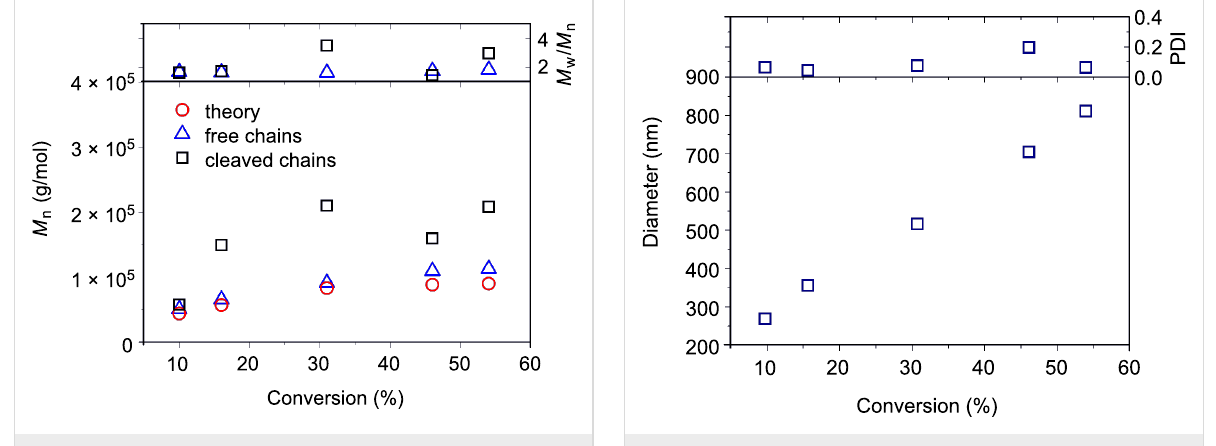
Figure 5: Plot of the average diameter and PDI of particles recovered from silica-supported RAFT polymerization of